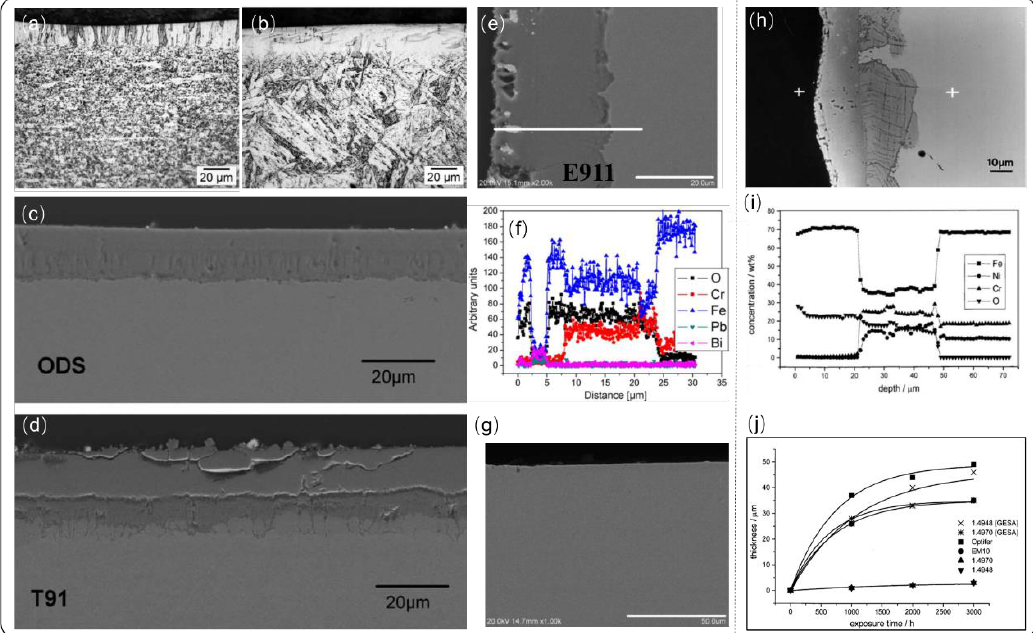
Figure 3. Gepulste Elektronen Strahl Anlage (GESA) treated coatings and corrosion performance. ( a , b ) Cross-sectional images of Al-coating on oxide dispersion-strengthened (ODS) and E911. ( c – e ) Cross-section images of the Al-coated ODS, T91 and E911 after corrosion test. ( f ) Element distribution of E911after GESA treatment. ( g ) Cross section of ODS with Al alloying. ( h ) Cross section of 1.4948 steel after GESA treatment. ( i ) Element distribution from EDX energy spectrum of EP911. ( j ) Summary of oxide layer thickness at 550 °C in flowing lead [65,66]. Figure 3a–g is reprinted with permission from ref [65]. Copyright 2006 Elsevier. Figure 3h–j is reprinted with permission from ref [66]. Copyright 2001 Elsevier.